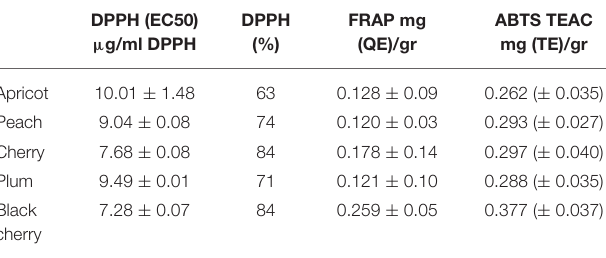
TABLE 2 | Anti-oxidant activity exhibited by the cold-pressed seed oils of apricot, peach, cherry, black cherry, and plum, assessed through the 2,2-diphenyl-1-picrylhydrazyl (DPPH), Ferric Reducing Antioxidant Power (FRAP), and 2, 20-azino-bis (3-ethylbenzothiazoline-6-sulfonic acid) (ABTS) tests.